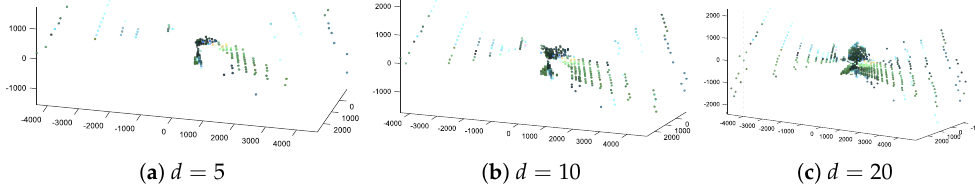
Figure 10. 3D reconstruction using DeepMatching. Figures ( a – c ) show the reconstruction with features filtered at d = 5, d = 10, and d = 20